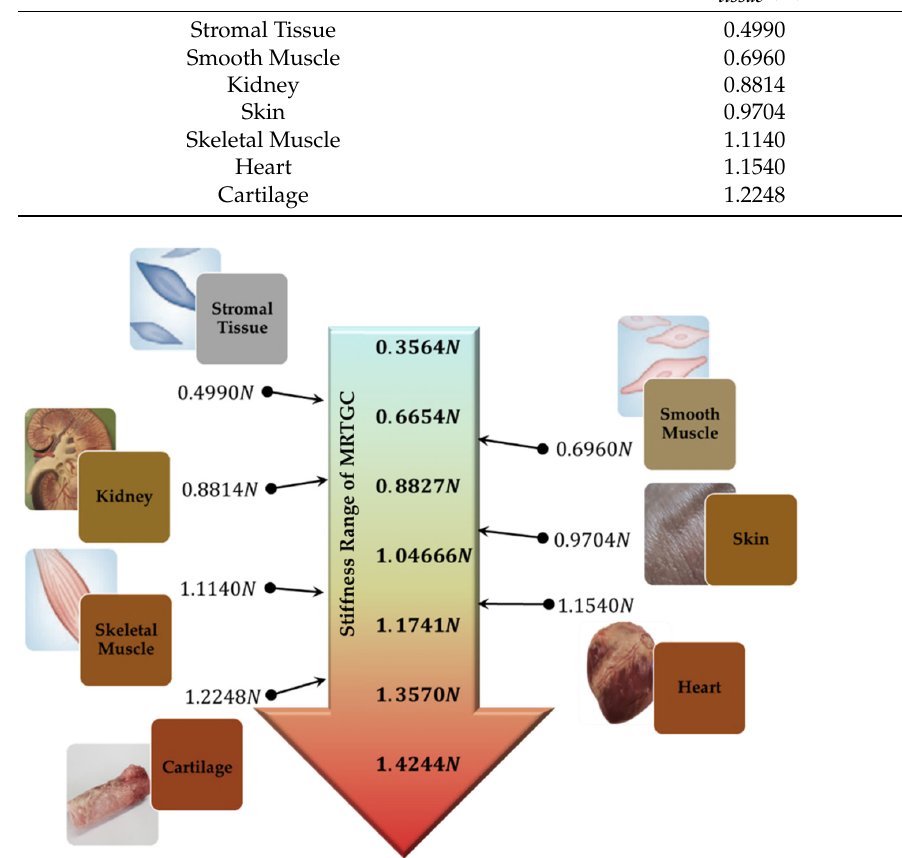
Figure 12. Comparison between MRTGC of stiffness calculated by simulation results and human tissue